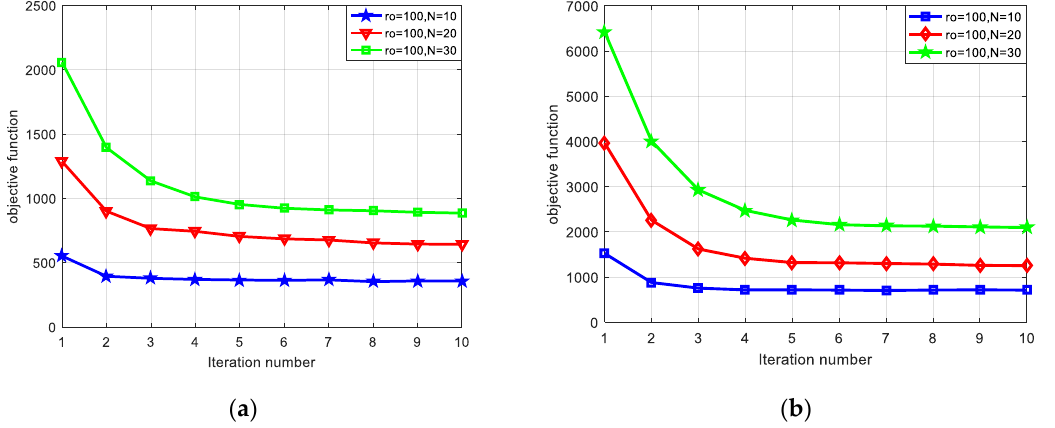
Figure 5. The iterative process of fairness performance in joint optimization. R o is 1500 m ( a ) and 2000 m ( b